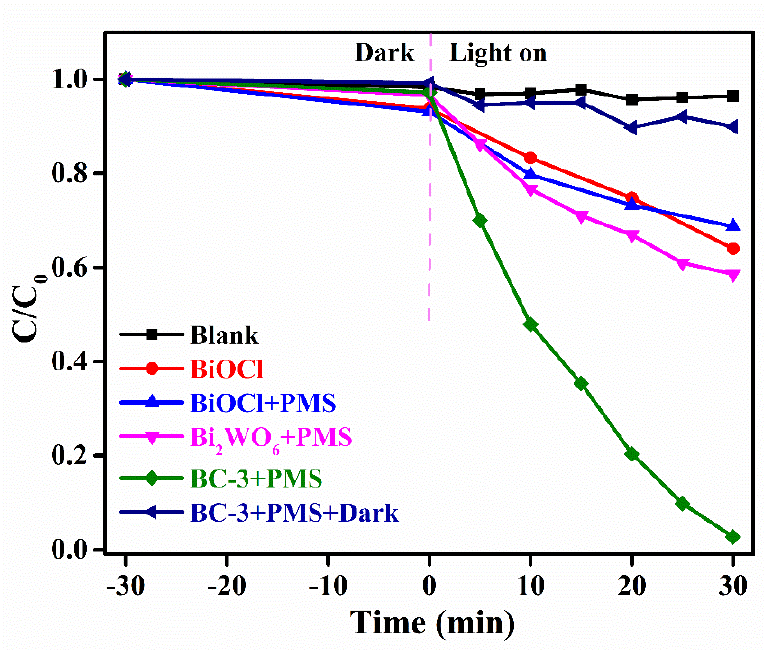
Figure 7. Photocatalytic properties of BPA degradation using various systems. Reaction condition: initial BPA concentration of 10 mg/L, PMS dosage of 1 mmol/L, catalyst addition of 1 g/L.